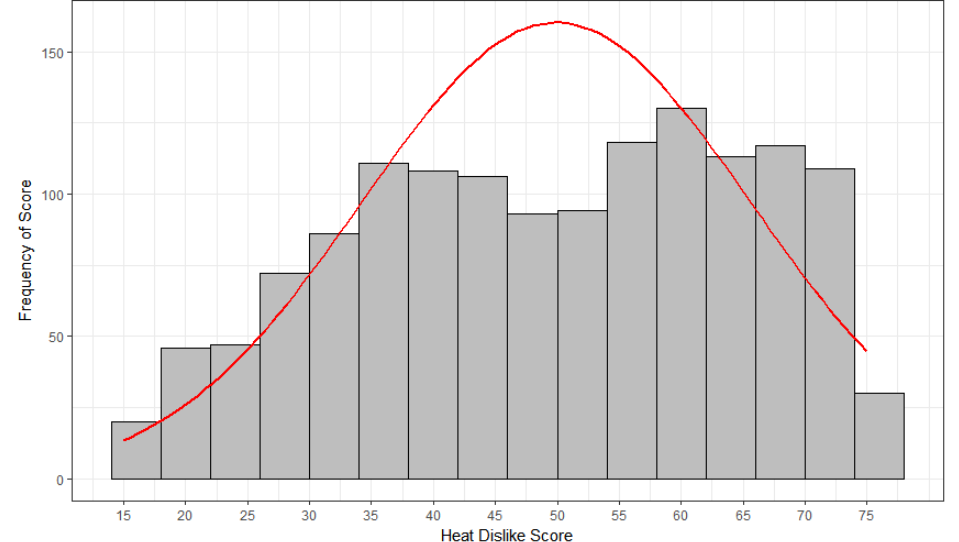
Figure 1. Frequency distribution of the total score on the Heat Dislike survey items with superimposed normal curve. (Note: Higher scores indicate greater dislike of heat).